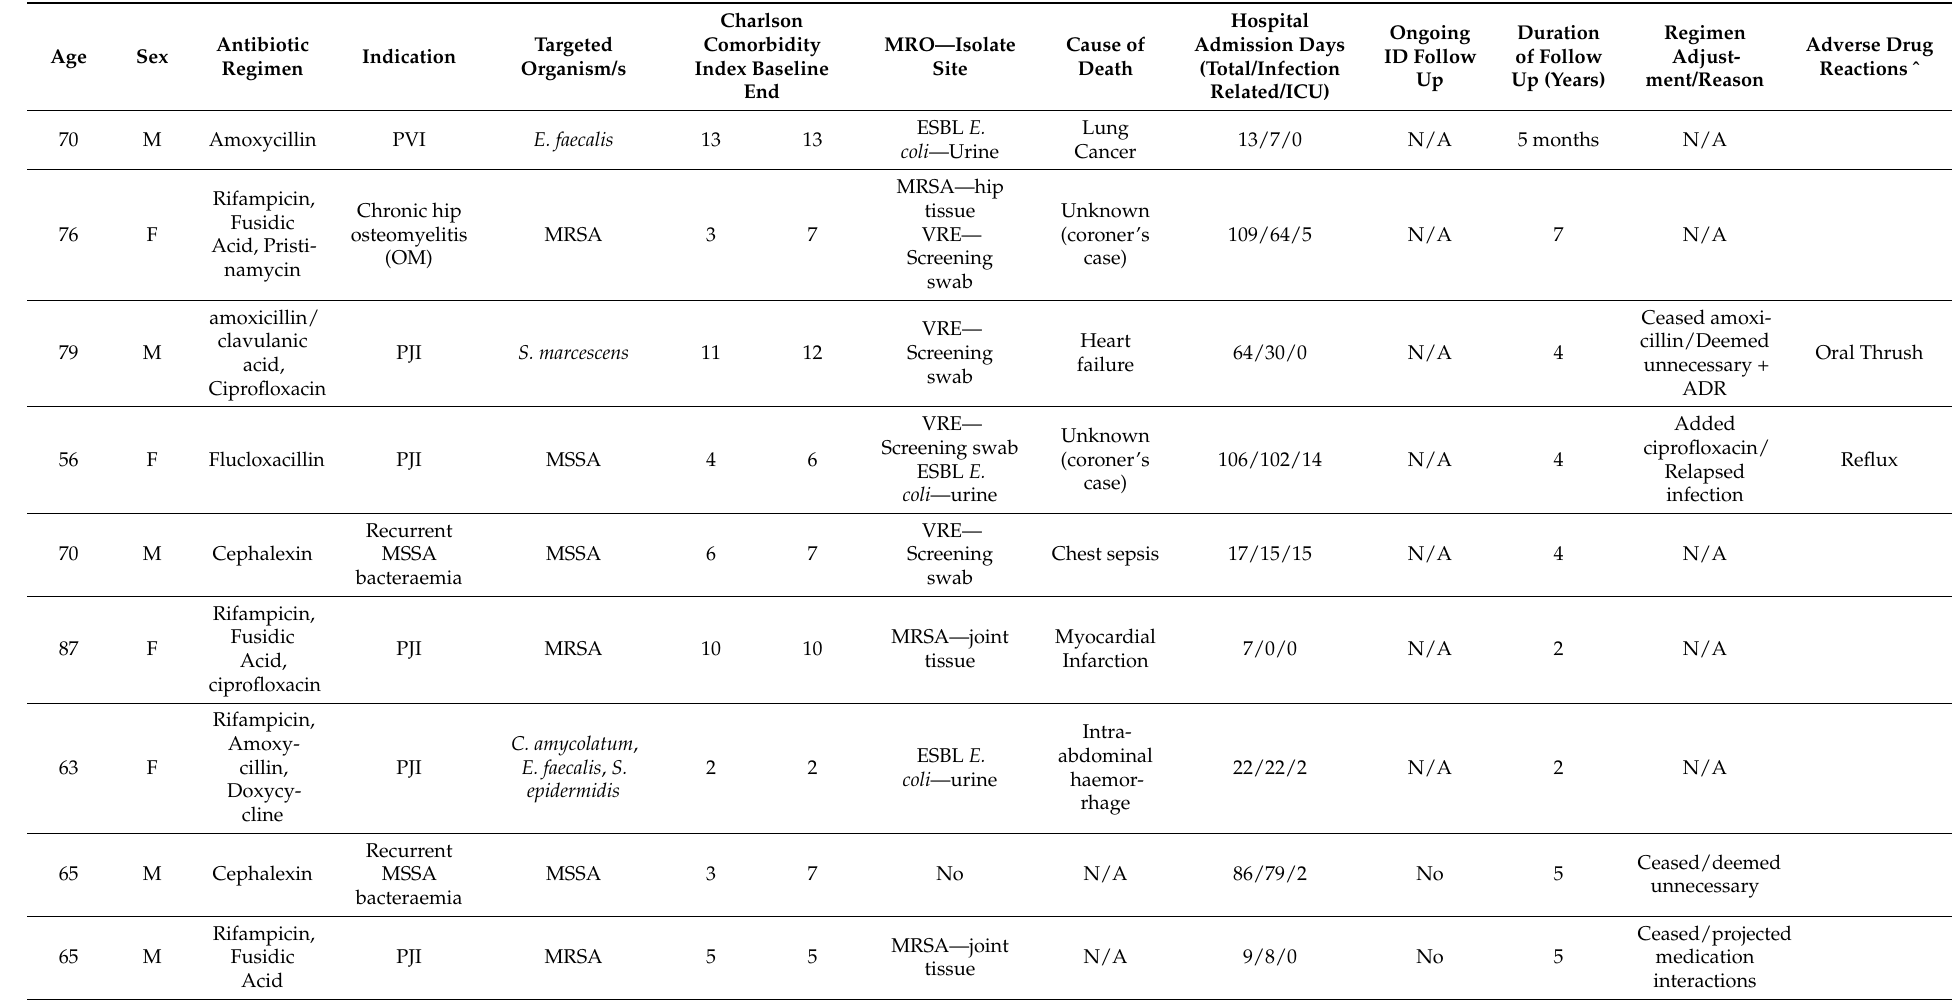
Table 1. Patient